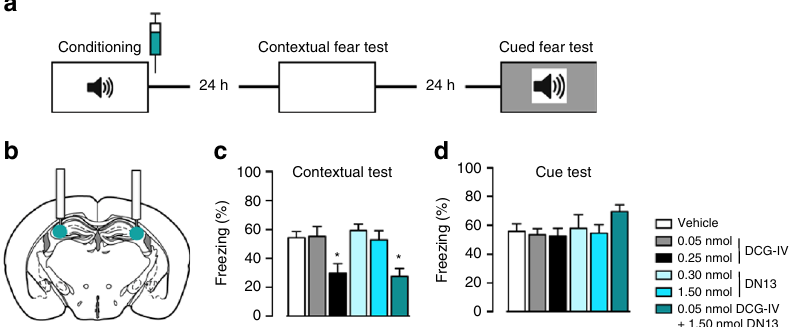
Fig. 6 mGlu2 receptors in the CA3 area of the hippocampus control contextual fear consolidation. a Schematic of the experimental protocol used for the contextual fear consolidation examination in mice, and drug infusion site b . c Contextual fear memory expression. ANOVA: F 5,35 = 6.025, P = 0.0004. d Cued fear memory. ANOVA: F 5,35 = 0.3053, P = 0.9066. * P < 0.05 vs. PBS and ** P < 0.01 vs.